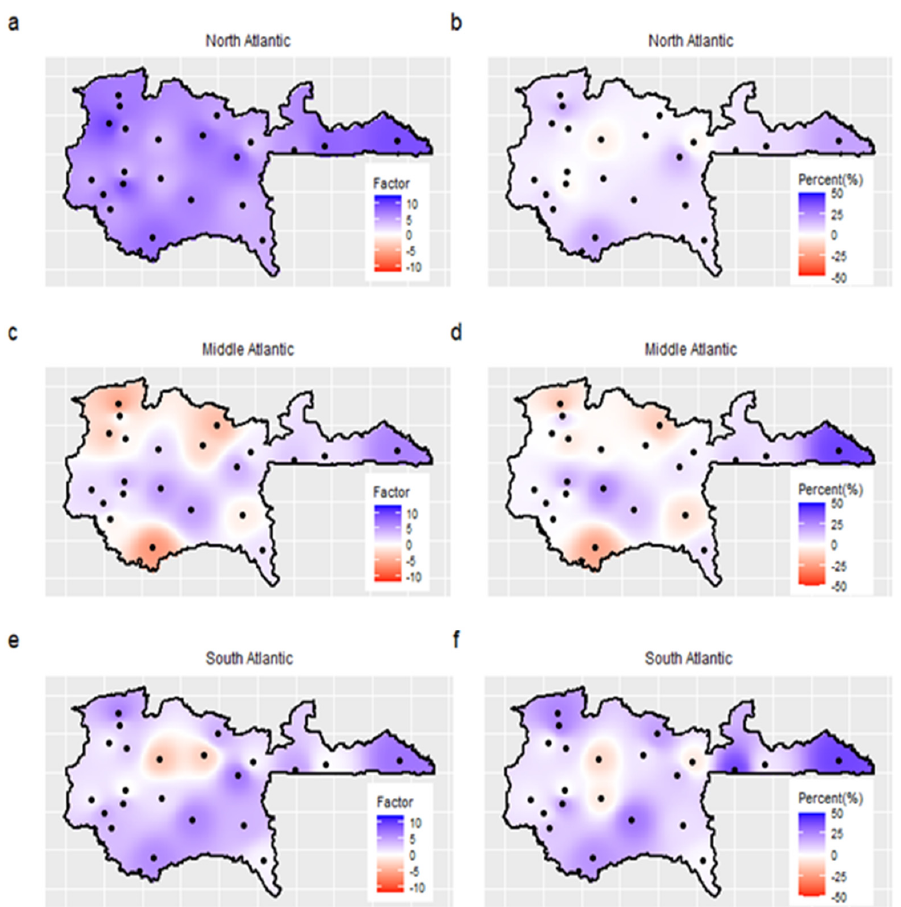
Figure 5. Slope values of the linear relations between SST and extreme rainfall. Left column : Slope values ( β 1, s , β 2, s , and β 3, s ) for the frequency of extreme rainfall. A value of n means an n-fold increase in the frequency of extreme precipitation per ◦ C increase in SST. Right column : Slope values ( α 1, s , α 2, s , and α 3, s ) for the intensity of extreme rainfall. A value of n means an n% increase in the intensity of extreme precipitation per ◦ C increase in SST. Rows represent the different covariates, i.e., SST of North Atlantic (upper), SST of Middle Atlantic (middle), and SST of South Atlantic (lower). The impact of Atlantic SST on extreme rainfall is estimated at the station level and interpolated spatially using the IDW method. The circles are rainfall stations. Figures ( a , c , e ) express the influence of upper, middle, and lower Atlantic SSTs, respectively, on the frequency of extreme rainfall. Figures ( b , d , f ) represent the influence of upper, middle, and lower Atlantic SSTs, respectively, on the intensity of extreme